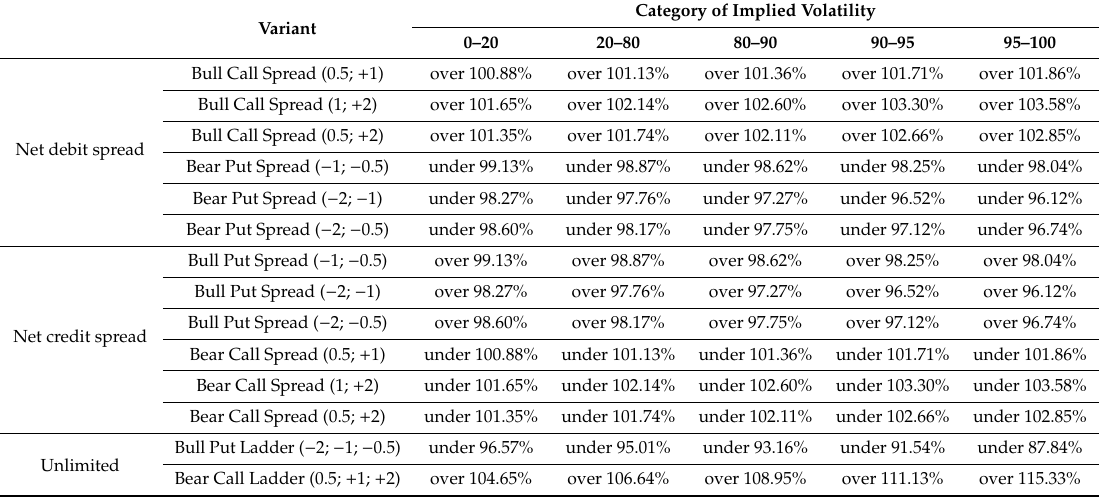
Table 4. Price ranges in which the individual variants of vertical spreads generated a profit.